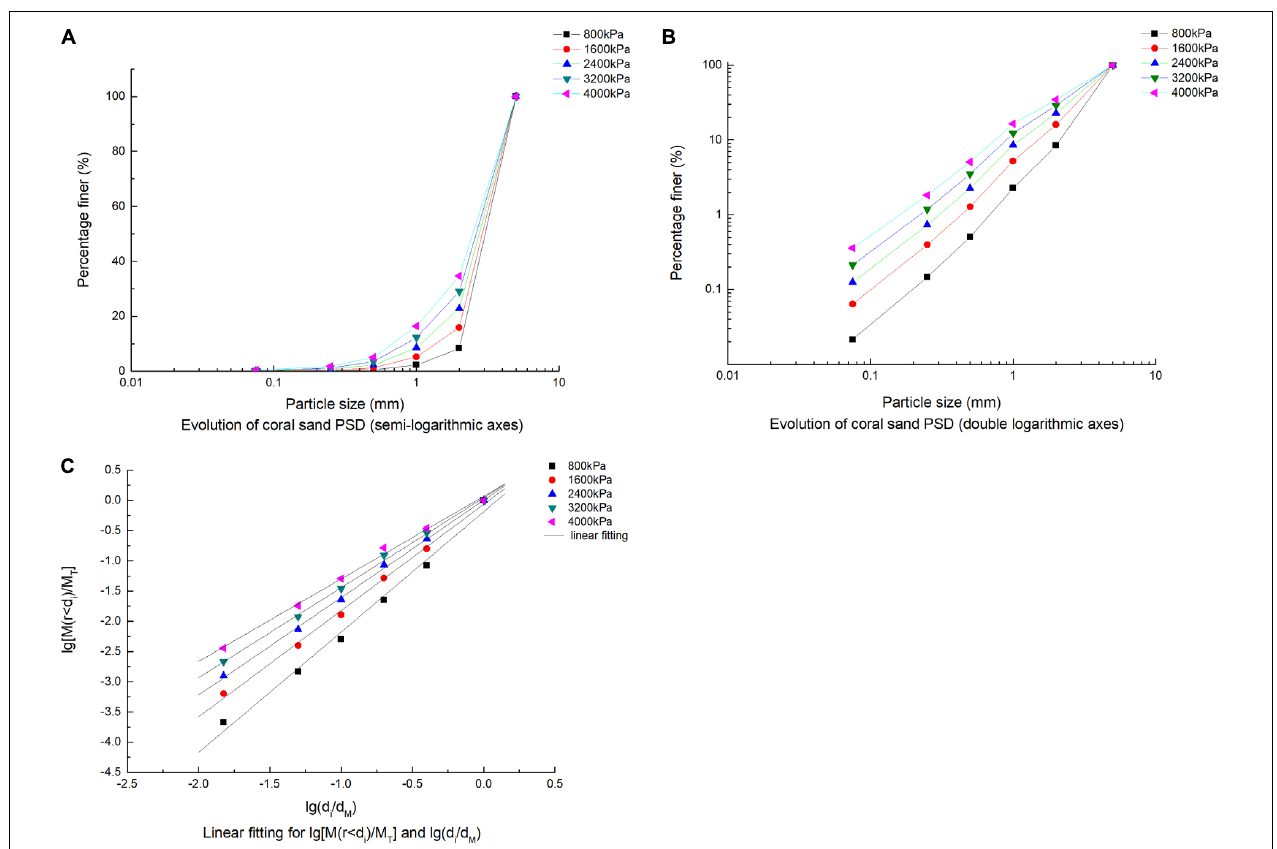
FIGURE 10 | Evolution of particle size distribution in coral sand under higher stress (2–5 mm). (A) Evolution of coral sand PSD (semi-logarithmic axes), (B) Evolution of coral sand PSD (double logarithmic axes), and (C) Linear fitting for lg[M(r < d i )/M T ] and lg(d i /d M